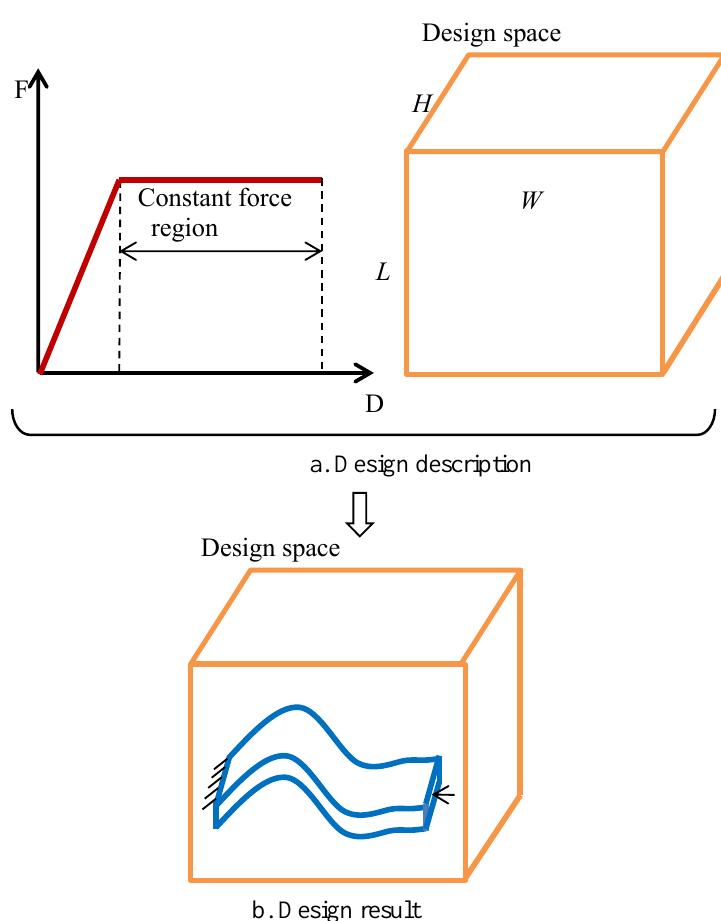
Figure 2. The illustration of the design problem. ( a ) Design description; ( b ) Design